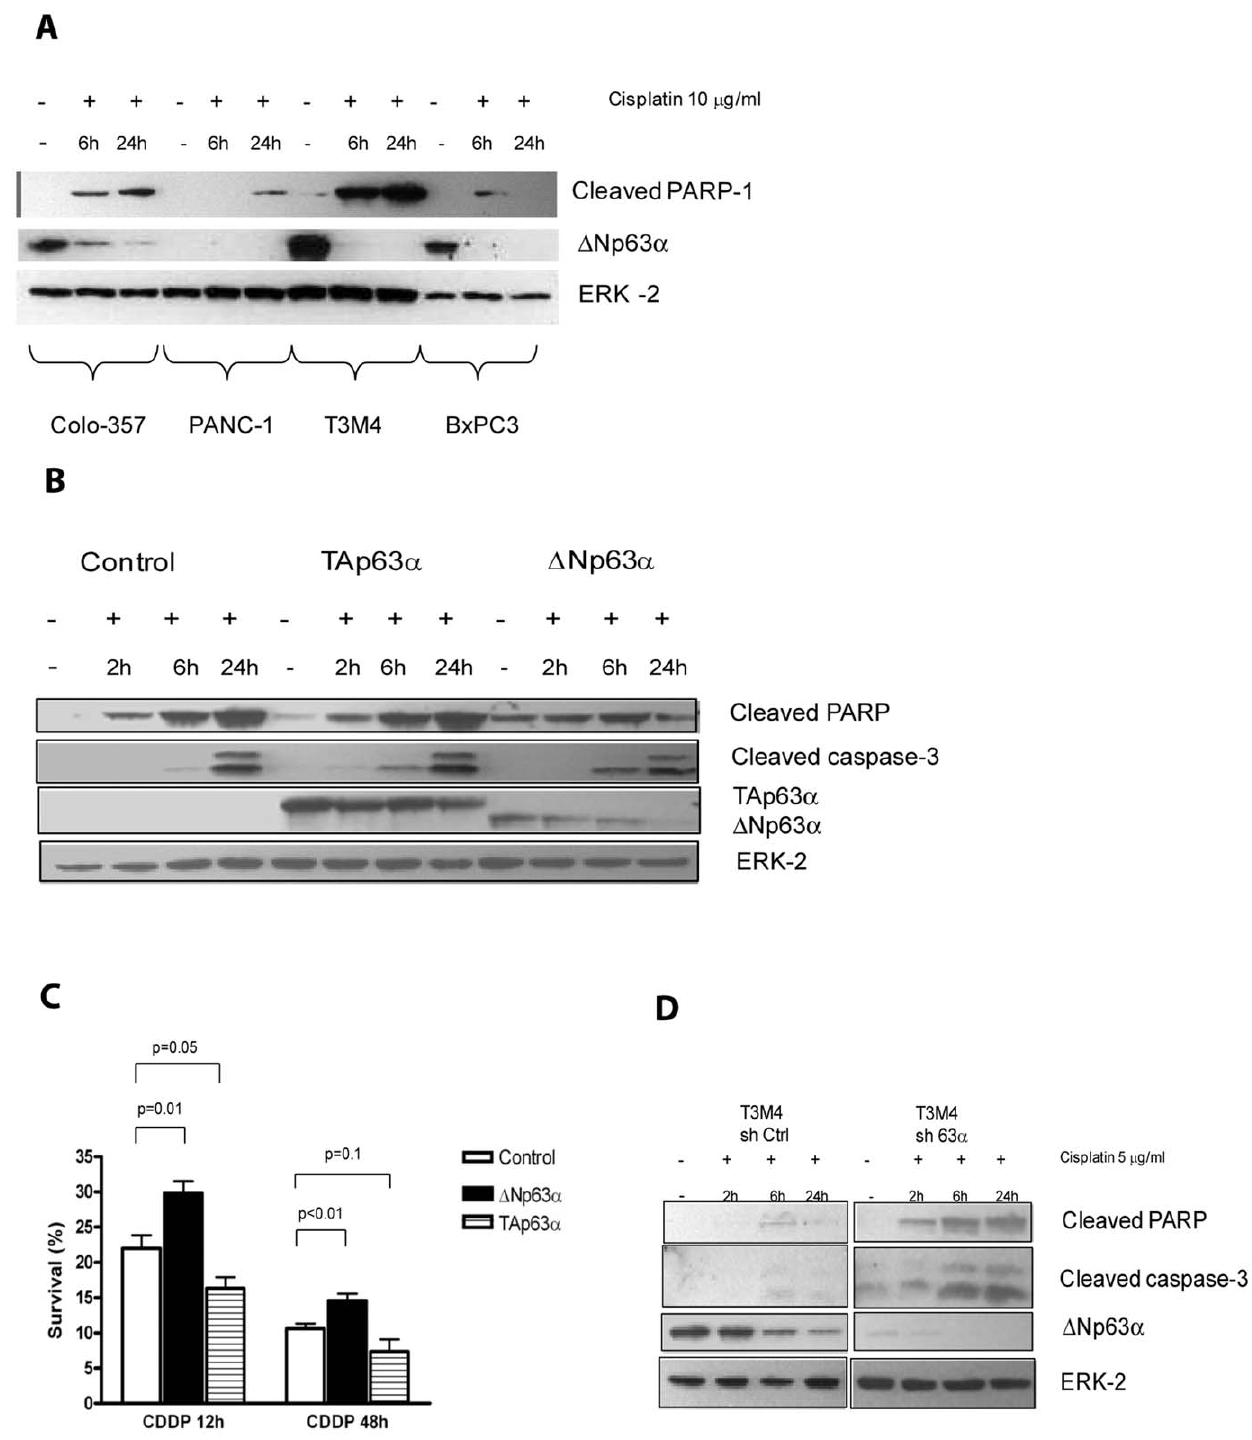
Figure 4. D Np63 a contributes to chemoresistance in pancreatic cancer cells. A , Effect of cisplatin on D Np63 a in PDAC. Cells were incubated with 10 m g/mL cisplatin for the initial 6 or full 24 hours. Apoptosis was assessed by monitoring PARP cleavage. B–D , Effect of D Np63 a on cisplatin- induced apoptosis in PANC-1 ( B, C ) and T3M4 cells ( D ). Cells were incubated with 5 m g/mL of cisplatin during indicated time periods. Cells were pelleted after 24 h of incubation, proteins isolated and run on SDS-PAGE gel. Apoptosis was assessed by monitoring PARP and caspase-3 cleavage. A representative image of at least three independent experiments is shown. PANC-1 cells were incubated with 10 m g/mL of cisplatin for the first 12 hours or full 48 hours. MTT assay was done as described in materials and methods. Data are the mean 6 SE of three independent experiments.